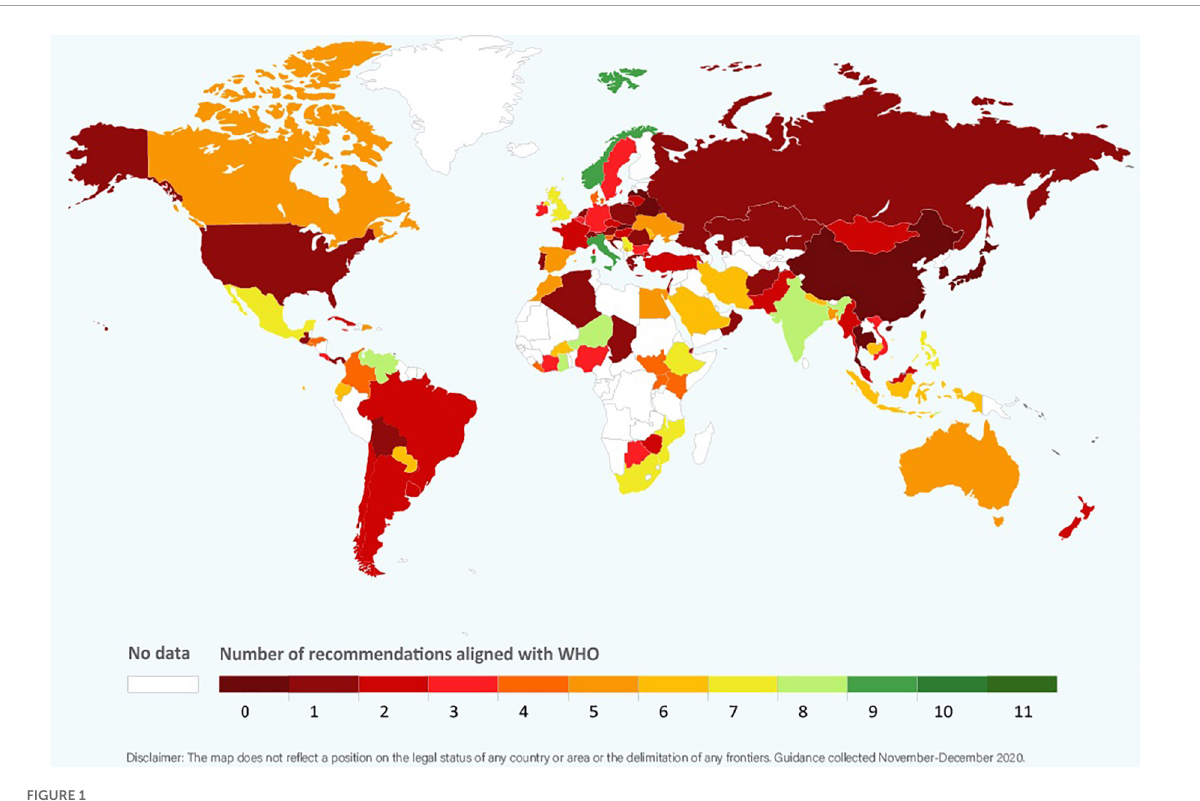
FIGURE1 Global alignment with WHO recommendations (score 0 to 11; data from 101 countries).